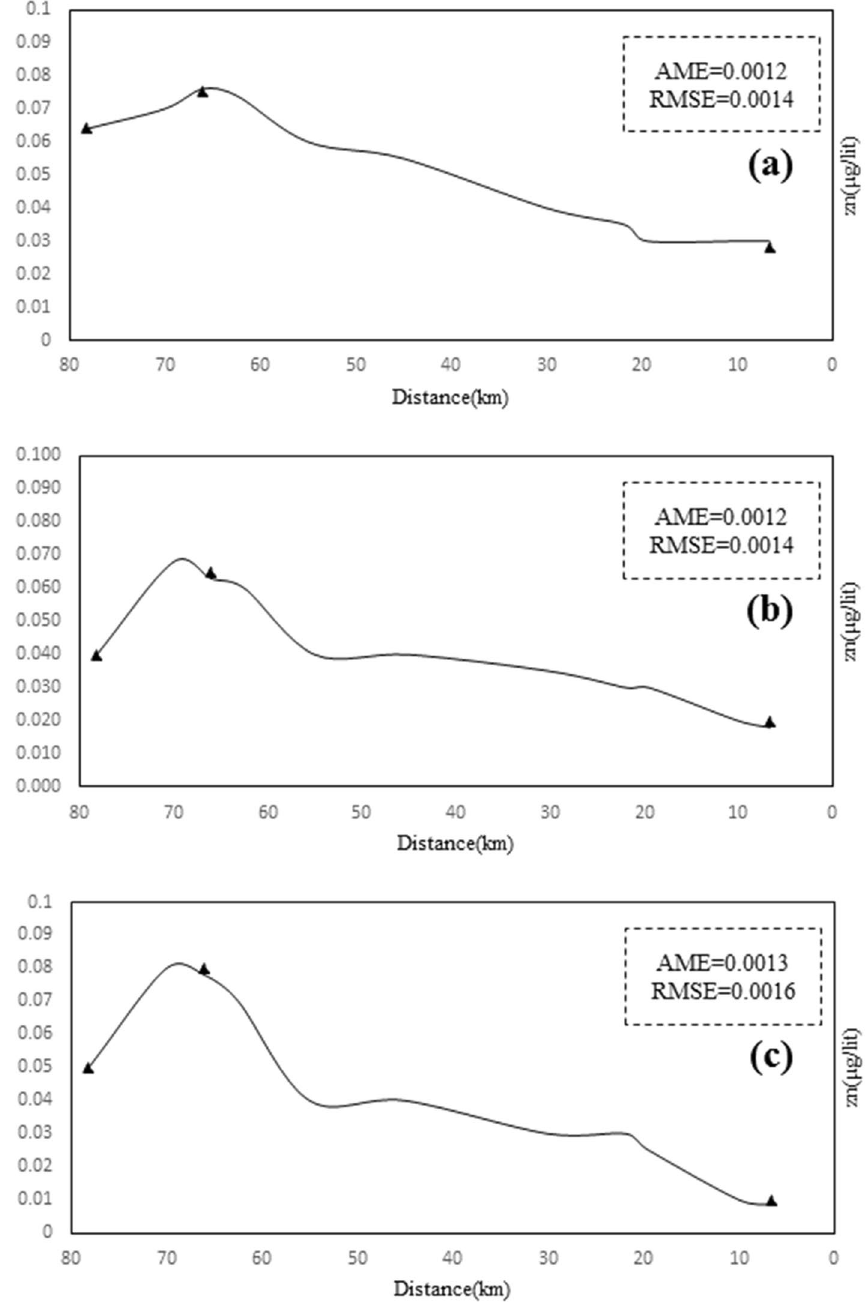
Figure 11. Zn Concentration on Sarouq River in ( a ) spring, ( b ) autumn, ( c ) winter in the developed Qual2kw